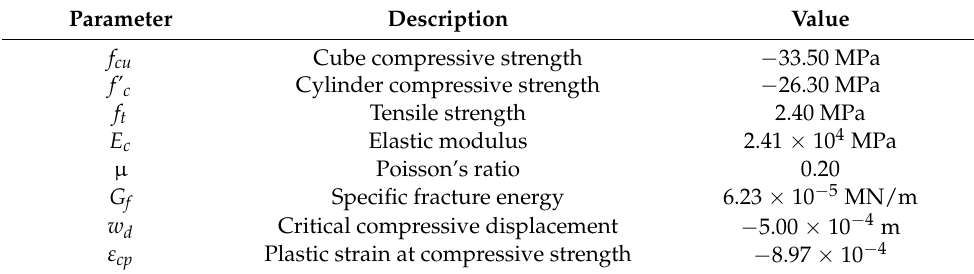
Figure 14. Constitutive laws of concrete and mortar: ( a ) compressive hardening; ( b ) compressive softening; ( c ) tensile softening. Table 6. Key input parameters of the concrete.